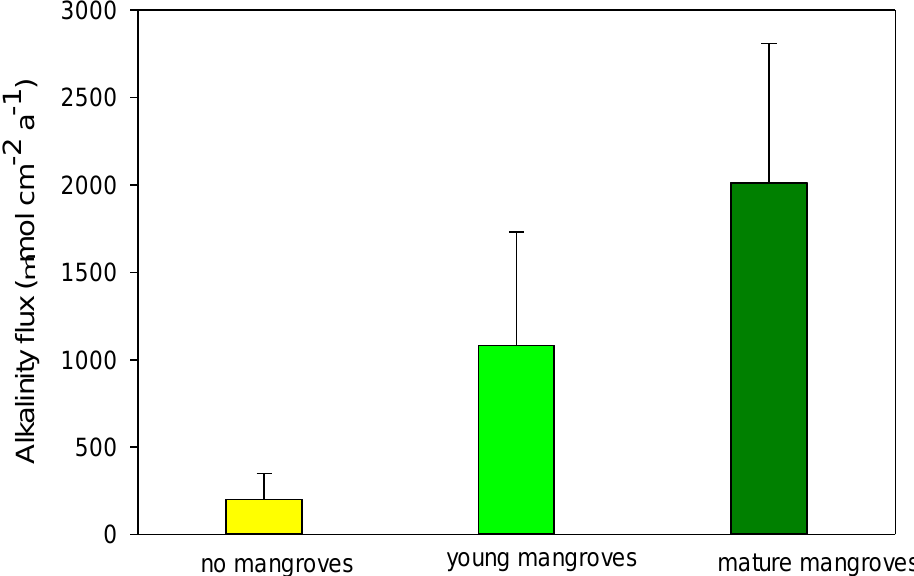
Figure 1. Model estimates of total alkalinity release from mature restored mangroves, young, restored mangrove stands and sediments without mangroves. Increasing rates of alkalinity release results in increasing rates of CDR (see text). Modified from Fakhraee et al. [69]. Reproduced via requirements of open access under the CC Attribution 4.0 International License (http://creativecommons.org/licenses/by/4.0, accessed 3 October 2022).